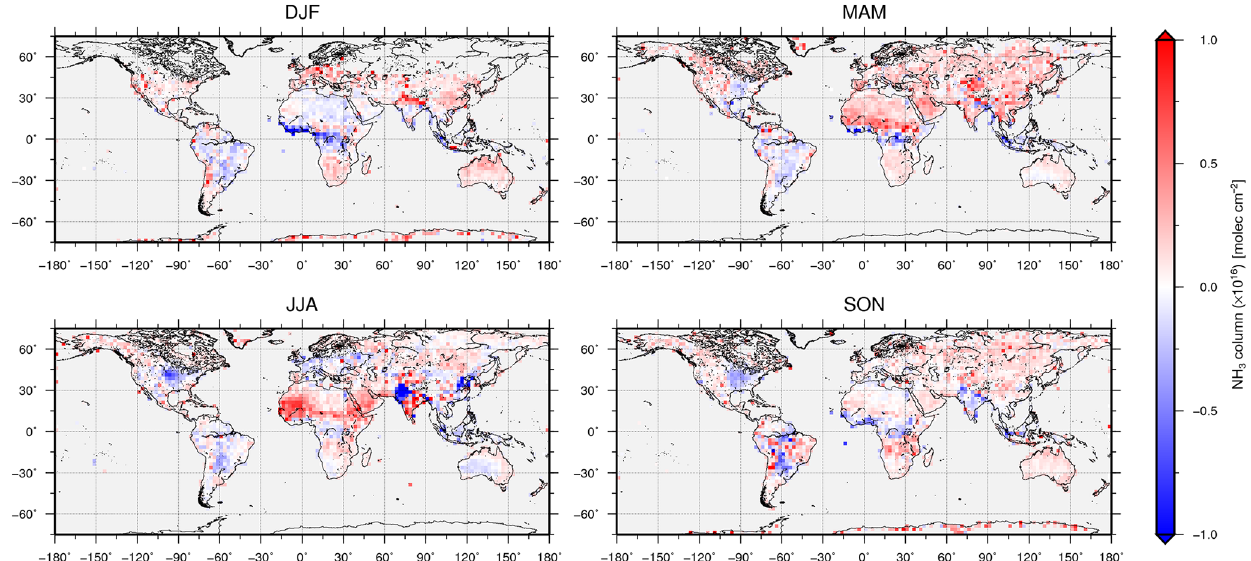
Figure 8. Same as Fig. 3, but for the difference between the GOSAT and the IASI ammonia column amounts. The red color indicates that the GOSAT data are higher than that from